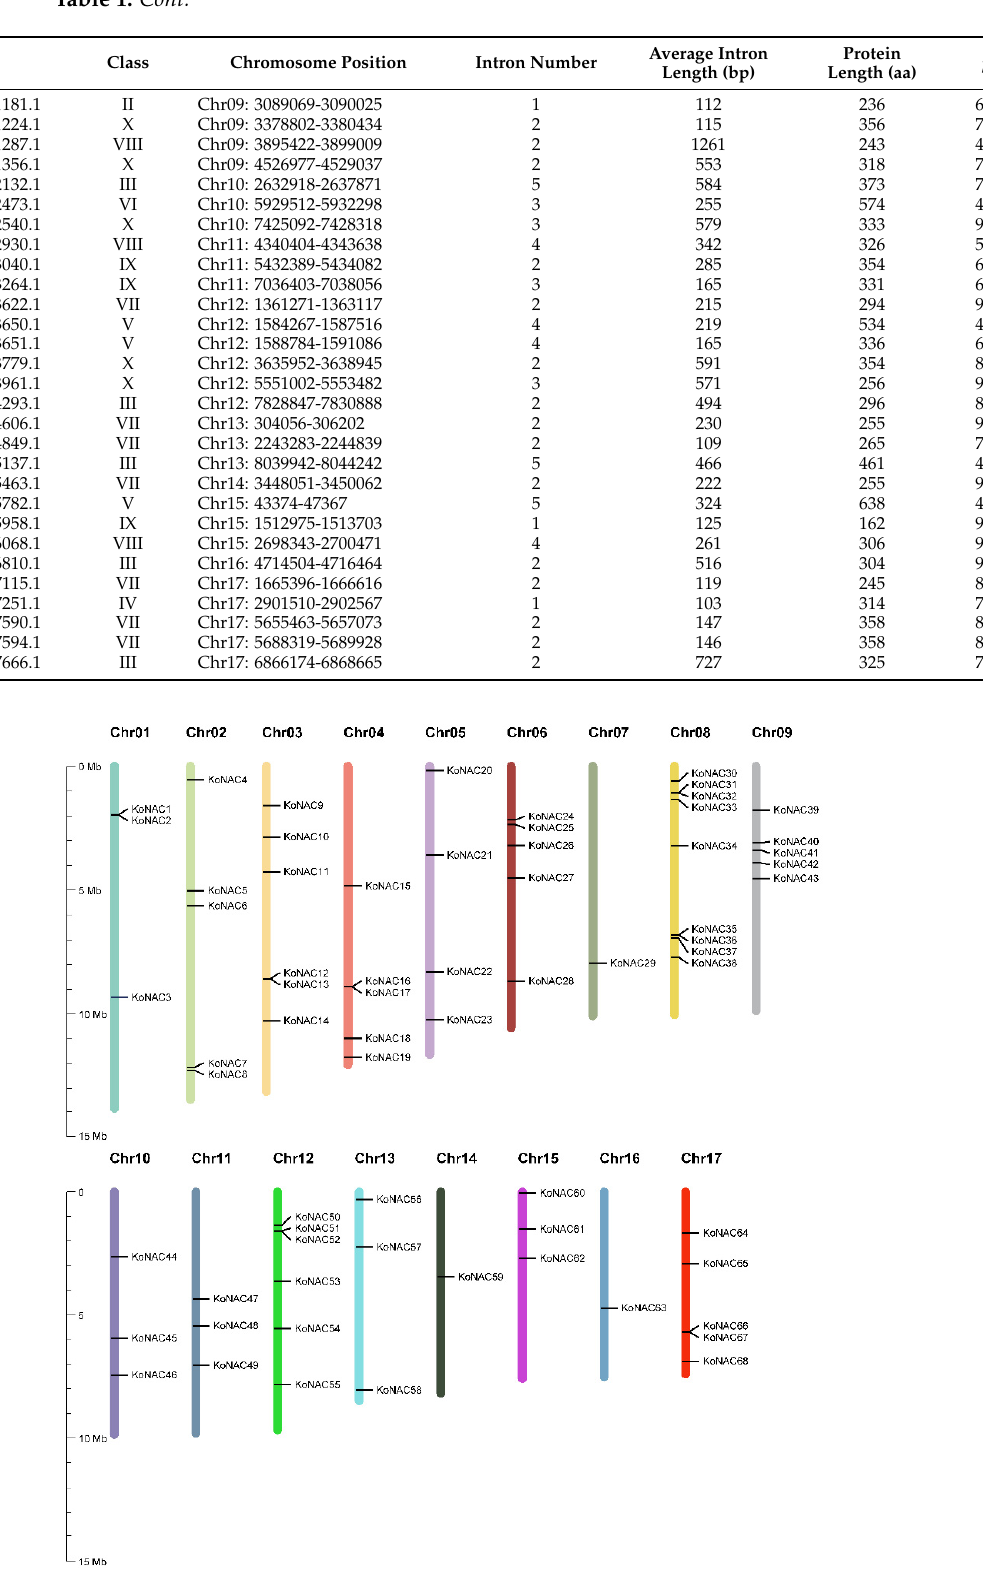
Figure 1. Distribution of Ko NAC genes in K. obovata genome. The 68 Ko NAC genes were unevenly distributed on 17 chromosomes (Chr01–Chr17) denoted in different colors, while no Ko NAC gene was found on Chr18. Values on the y-axis indicate the chromosome length and gene position. Table 1. Basic information of K. obovata NAC genes.